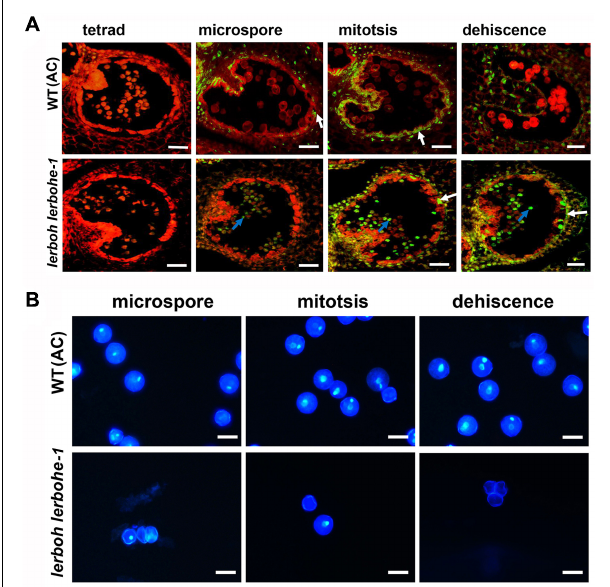
FIGURE 6 | lerboh lerbohe anthers exhibited delayed tapetum PCD and abnormal pollen nuclei. (A) TUNEL analysis of anthers. Green fluorescence, TUNEL; Red fluorescence, propidium iodide staining; white arrow, degraded tapetum layers; blue arrow, degraded pollens. Scale bar: 75 µ m. (B) DAPI staining of pollens. The bright, white dots are the pollen nuclei. Scale bar: 25 µ